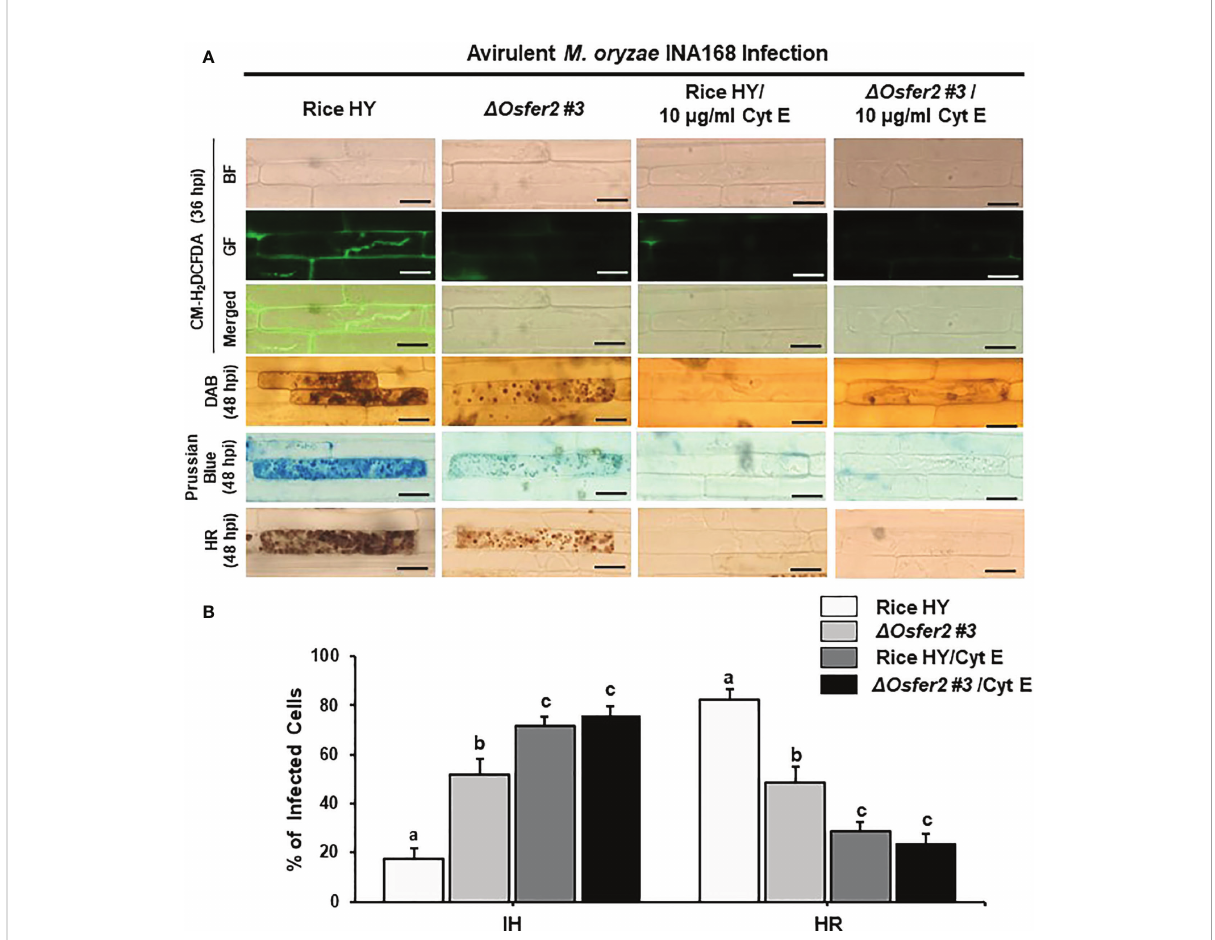
FIGURE 11 Treatment with cytochalasin E (Cyt E) inhibits ROS and ferroptotic HR cell death in the sheath epidermal layers of rice HY and D Osfer2 knock- out mutants infected with avirulent Magnaporthe oryzae INA168. (A) Microscopic images of HR cell death, DAB, Prussian blue and CM- H 2 DCFDA staining of rice sheath epidermal cells infected with M. oryzae INA168 and treated with Cyt E (10 µg/ml). Scale bar=20 µm. (B) Quanti fi cation of invasive hyphae (IH) and hypersensitive response (HR) cell death in rice sheath cells inoculated with M. oryzae and treated with Cyt E The rice sheath epidermal layers were incubated in 10 µg/ml cytochalasin E (Cyt E) for 24 h in dark condition at 25°C after inoculation with M. oryzae conidia (4×10 5 conidia mL − 1 ). The values are means ± SD; n=4 leaf sheaths from different plants. Different letters above the bars indicate signi fi cantly different means (P<0.05), as analyzed by one-way ANOVA analysis. hpi, hour post-inoculation; HR, hypersensitive response; BF, bright fi eld; GF, green fl